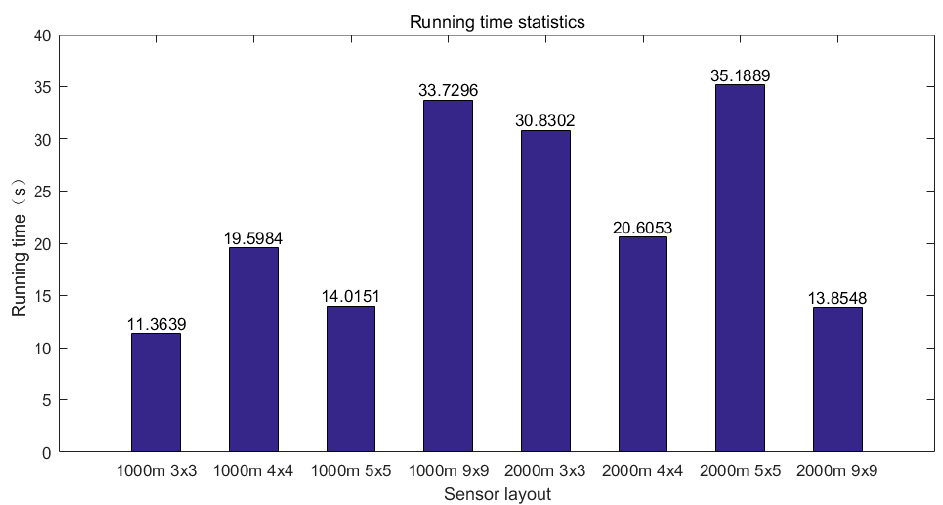
Figure 13. Statistics of the average running time of the algorithm.